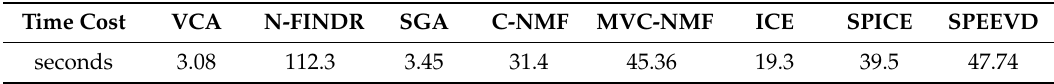
Table 8. The average running time of all methods on simulation image.